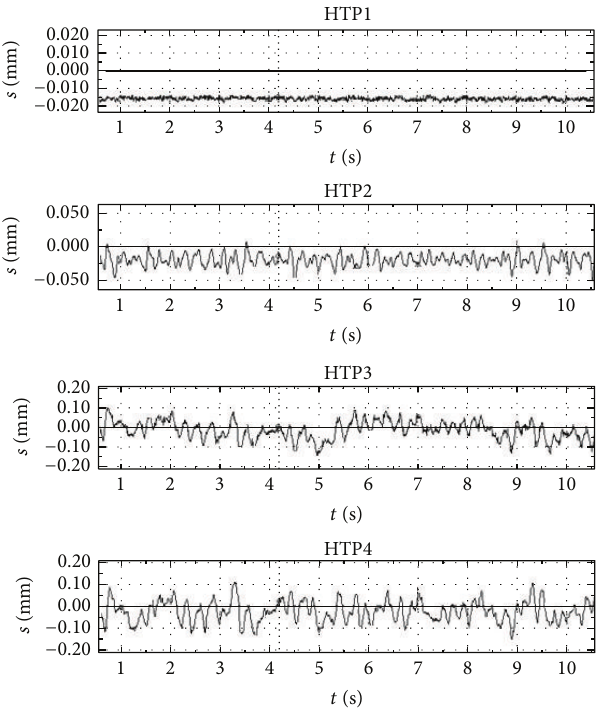
Figure 10: Horizontal vibration displacement in 𝑋